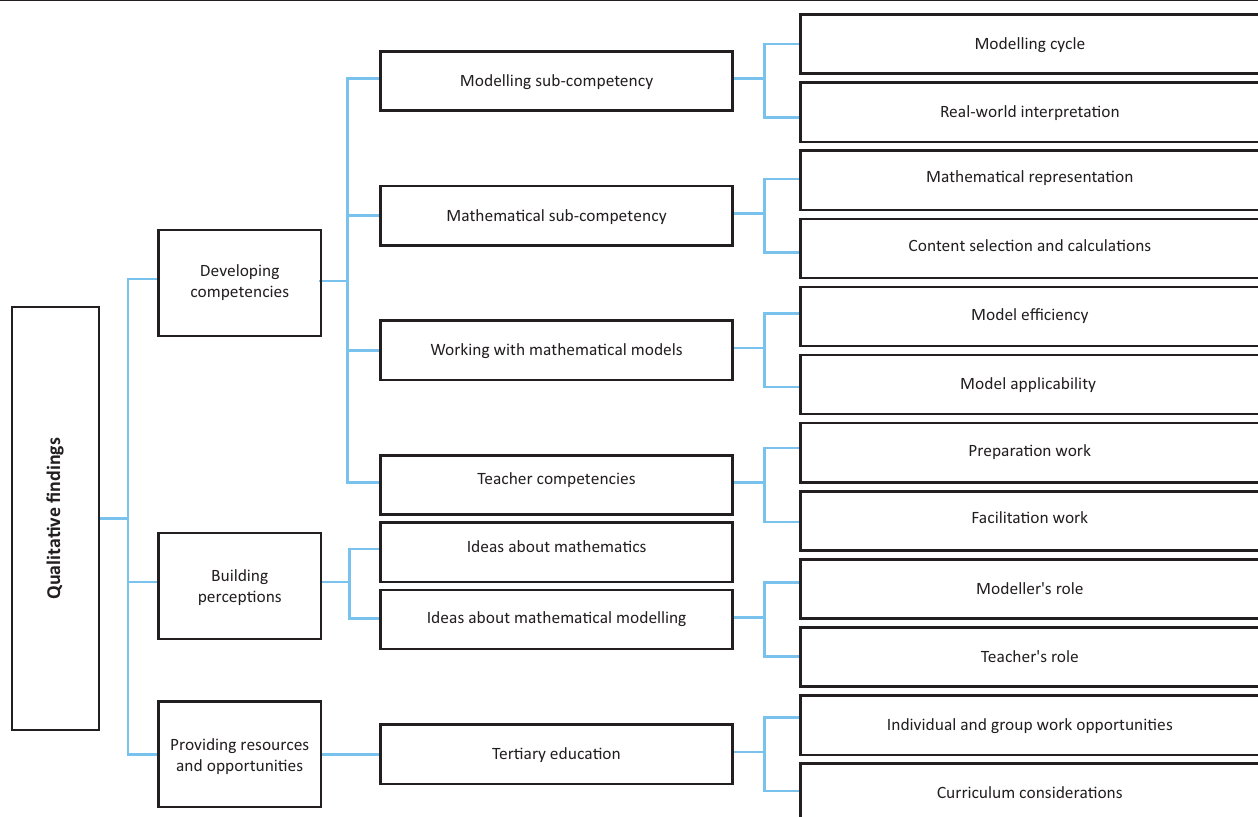
Developing competencies